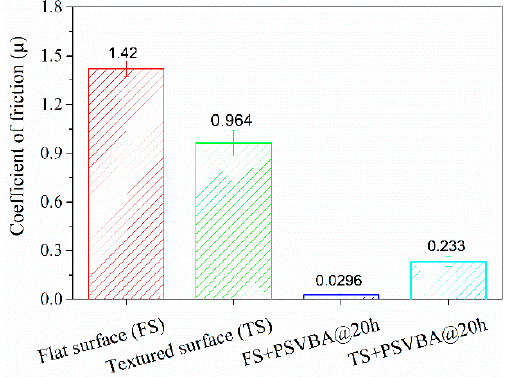
Figure 8. Average friction coefficients at the initial stable stage for different modifications.